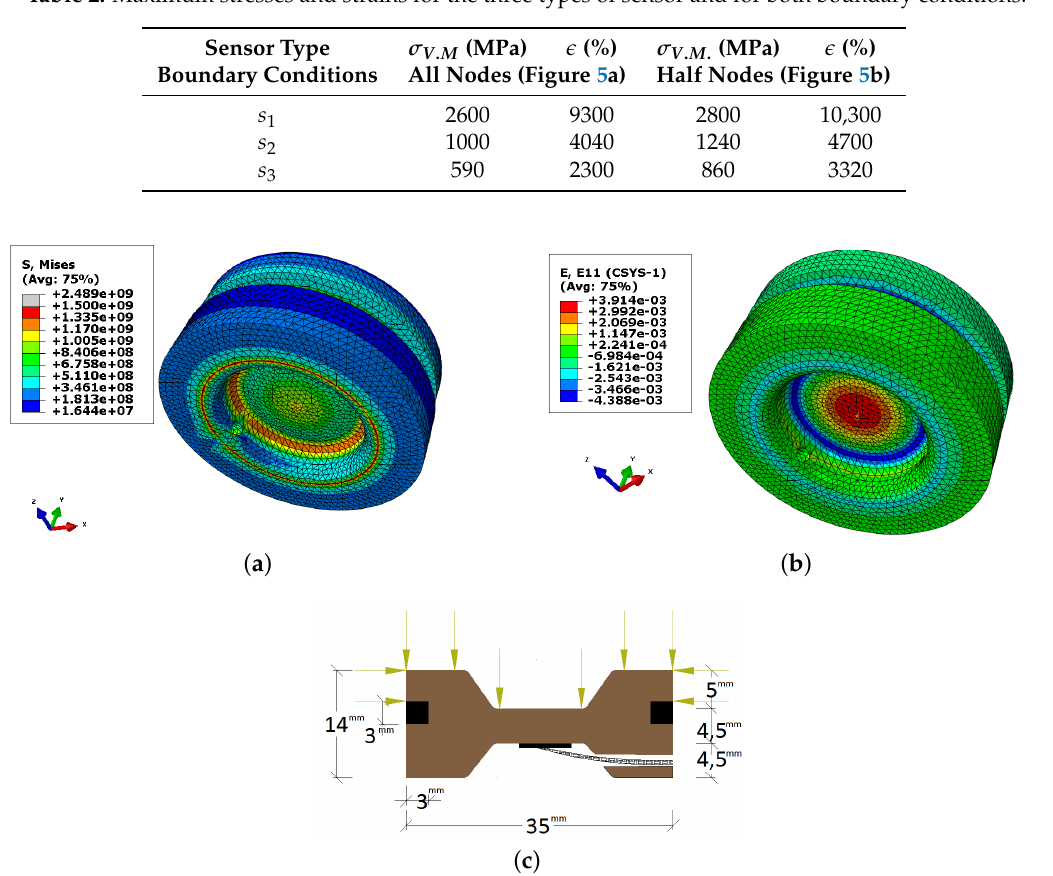
Figure 7. Sensitivity analysis: ( a , b ) stress and strain numerical simulation results; and ( c ) s2 sensor final